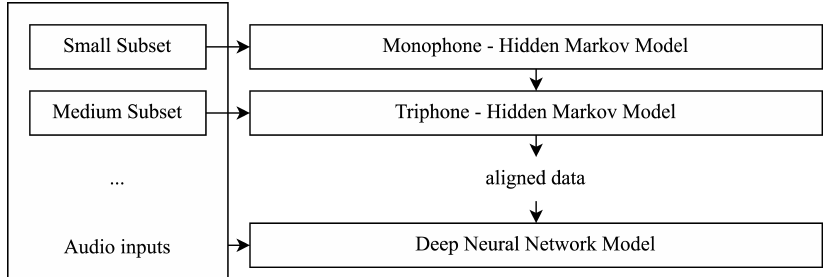
Figure 7. Training pipeline for Automatic Speech Recognition system.